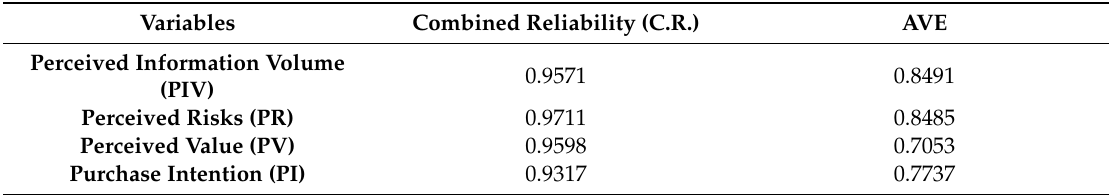
Table 5. Combined reliability and AVE.